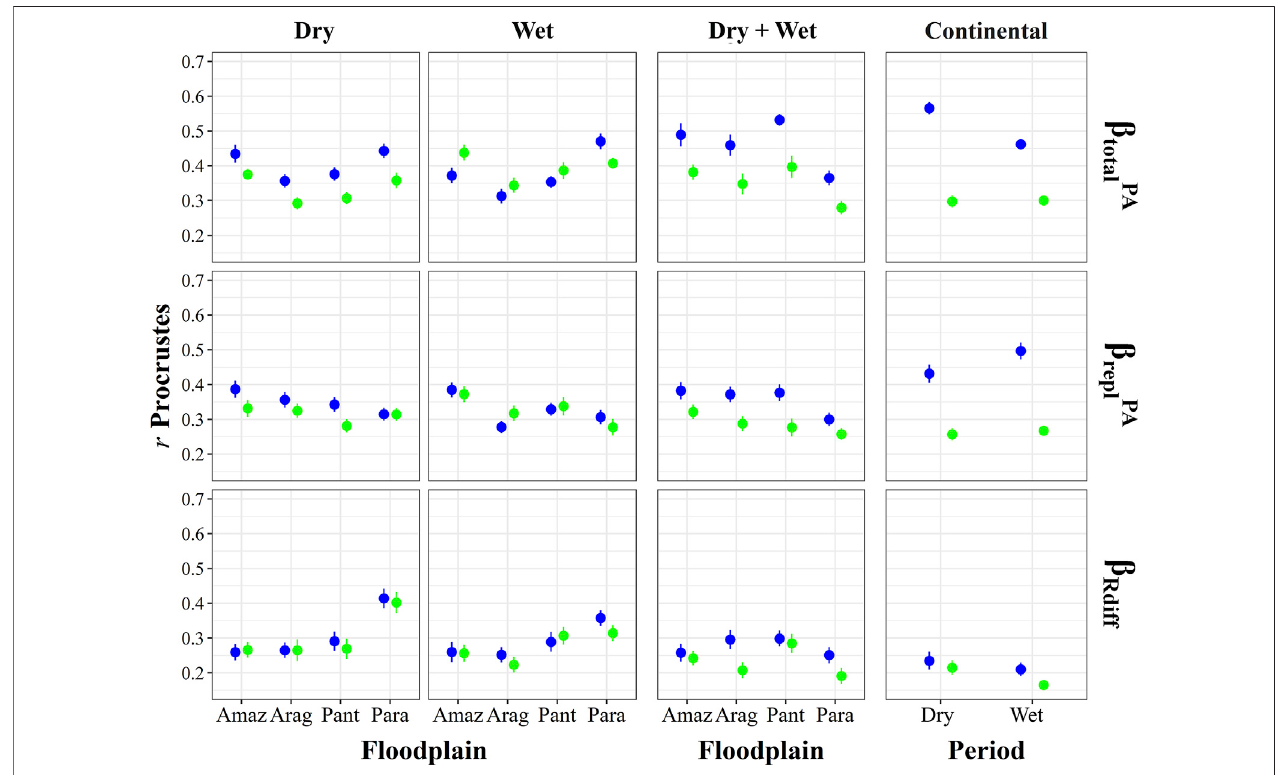
FIGURE 3 | Mean and standard deviation of congruence calculated from all pairs of combinations between biological groups for presence-absence data. Blue, Taxonomic facet; Green, Functional facet; Amaz, Amazônia; Arag, Araguaia; Pant, Pantanal; Para, Paraná.